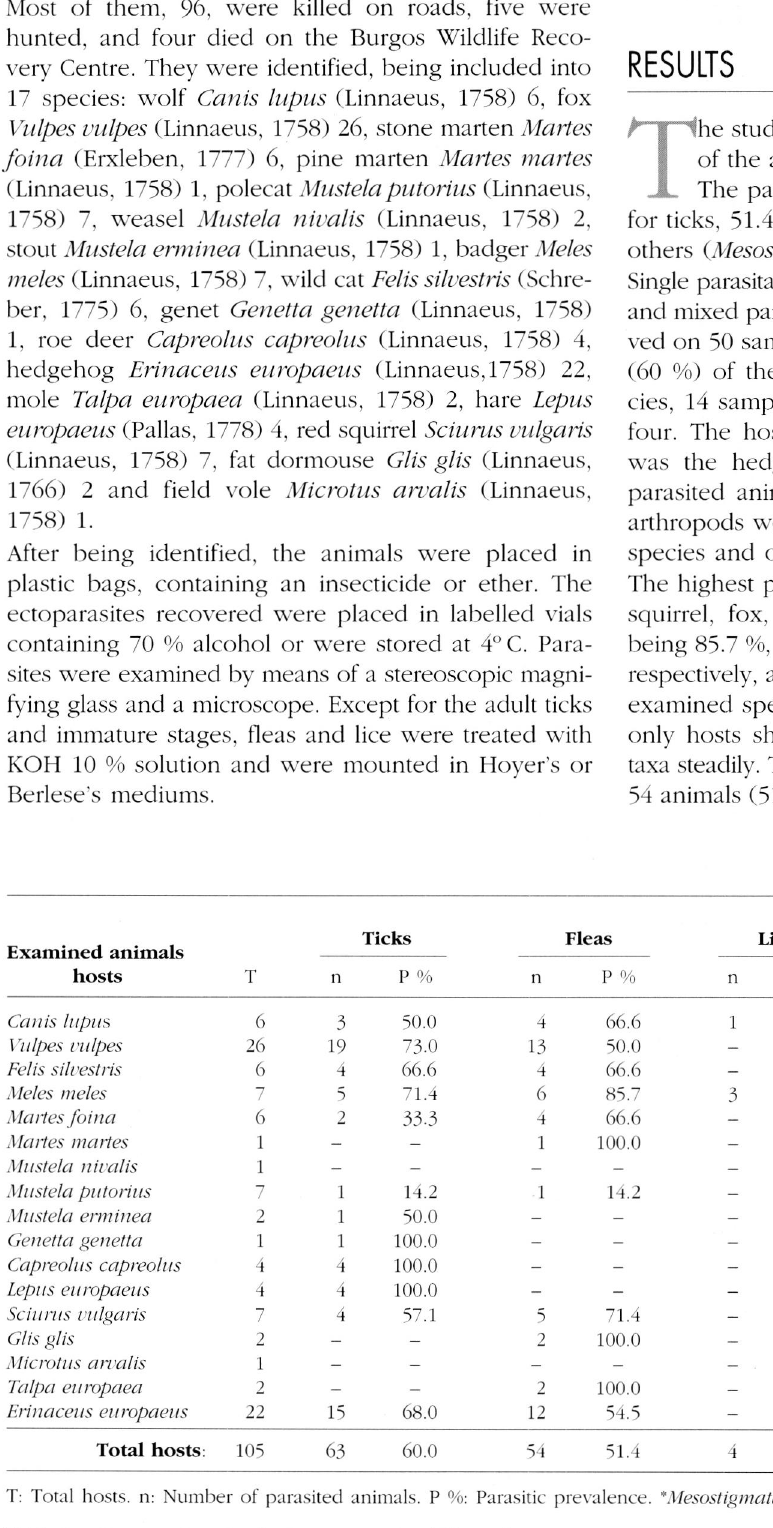
Table I. - Ectoparasites distribution among the different host species.